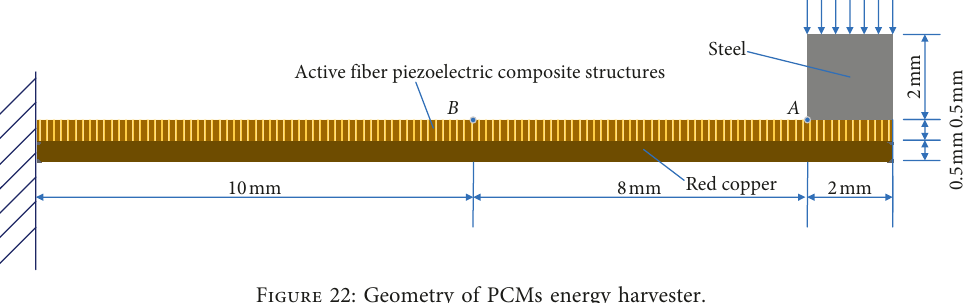
Figure 22: Geometry of PCMs energy harvester.